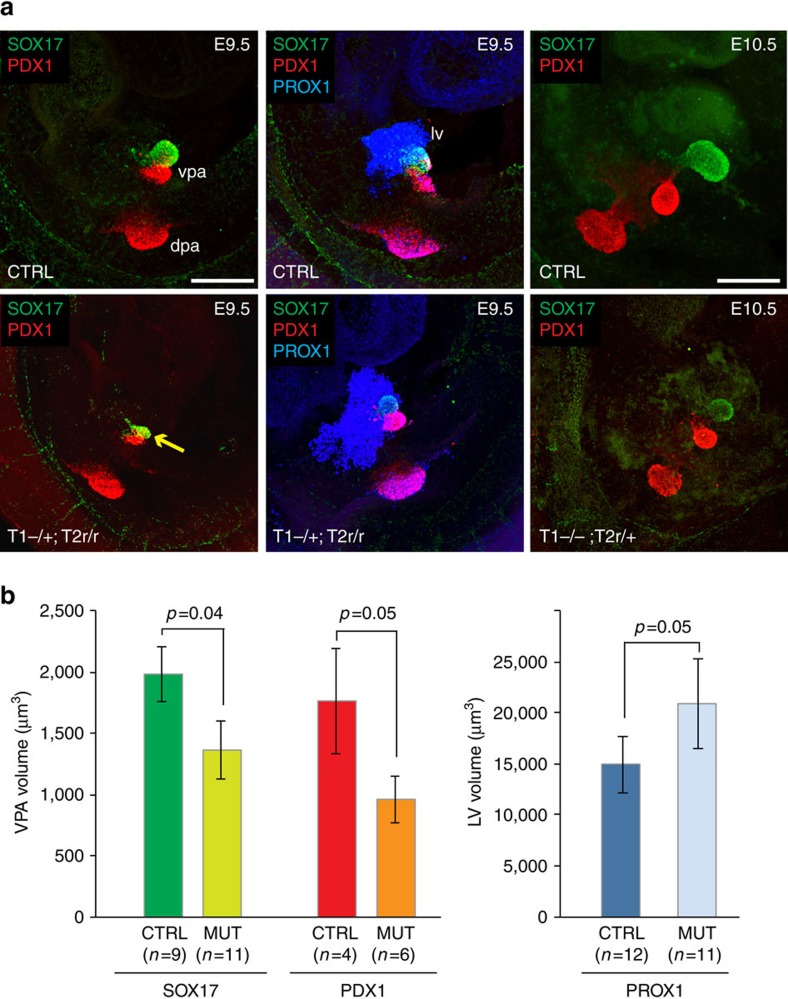
The TALE Tgif gene family controls lineage segregation within the ventral foregut endoderm of the mouse embryo.(a) Representative maximum confocal z-projections of PDX1/SOX17 and PDX1/SOX17/PROX1 IF analyses in control (CTRL), Tgif1−/−;Tgif2lox/+;Sox2-Cre+ (referred to as T1−/−; T2r/+) and Tgif1+/−;Tgif2lox/lox;Sox2-Cre+ (referred to as T1+/−; T2r/r) mouse embryos. PDX1 (red) marked both dorsal and ventral pancreatic buds and at E9.5 co-localized with SOX17 (green) in the pancreatobiliary progenitor population that gives rise to the ventral pancreas, extrahepatic ducts, and gall bladder (arrow). PROX1 (blue) marked both liver and pancreatic buds. dpa, dorsal pancreas; lv, liver; r, recombined; vpa, ventral pancreas. Scale bars, 50 μm. (b) Quantification of the ventral pancreas and liver volume buds from confocal images of E9.5 embryos. Average fluorescence intensity of PROX1+ liver buds, SOX17+ and PDX1+ ventral pancreas buds was measured using the ‘object analysis' function in Huygens software. Error bars indicate±s.e.m. n, indicated for each genotype. Statistics by two-tailed t-test and P values are shown.